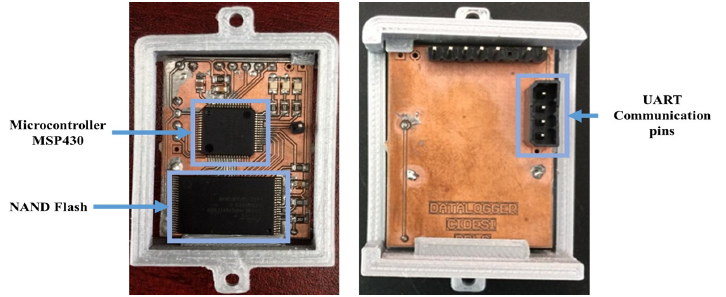
Figure 13. Datalogger printed circuit